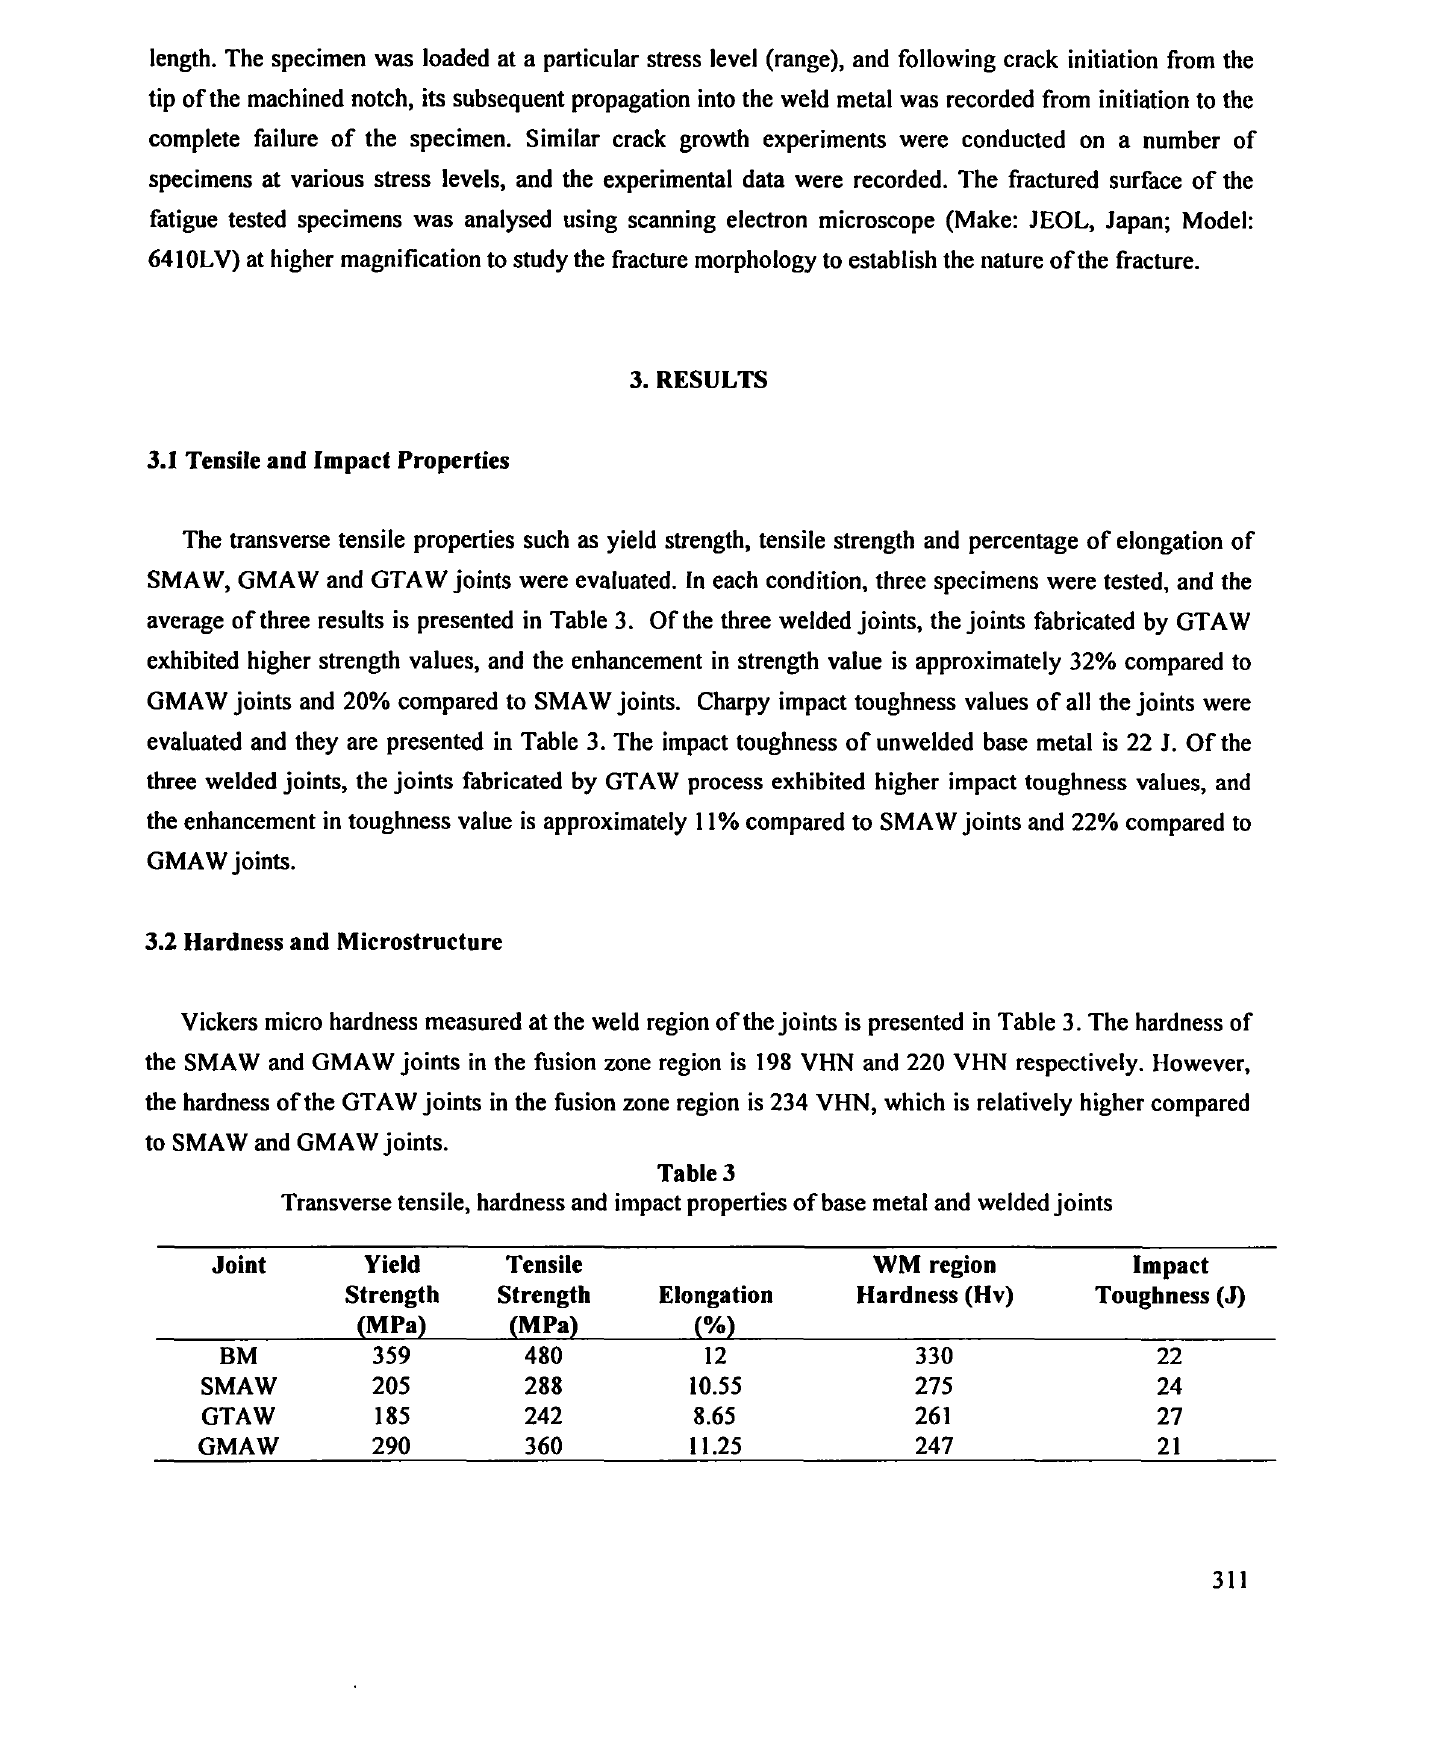
Transverse tensile, hardness and impact properties of base metal and welded